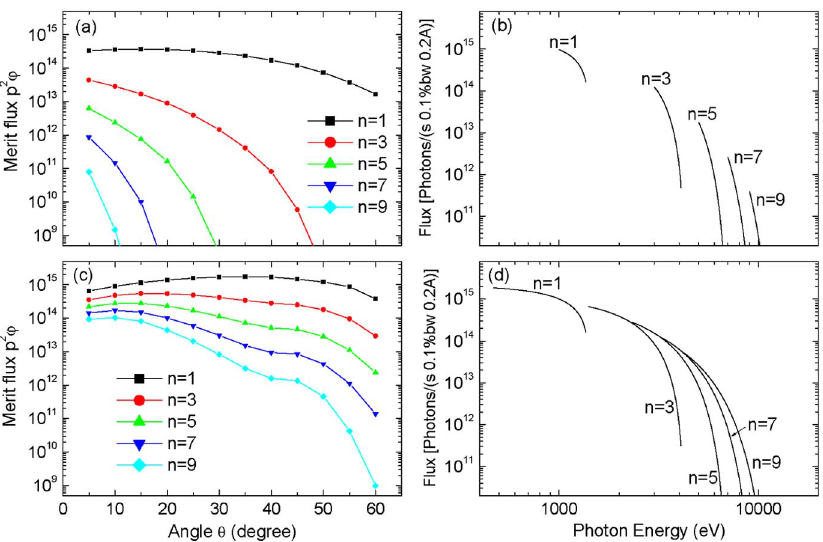
FIG. 9. (Color) Merit flux as functions of rotation angle (cid:6) , and the spectrum of the photon flux, for (a) and (b) the staggered undulator, with the photon flux in (b) calculated at (cid:6) (cid:1) 5 (cid:2) , and for (c) and (d) the racetrack coil undulator, with the photon flux in (d) calculated at (cid:6) (cid:1) 20 (cid:2) . The spectrum was calculated at an electron energy of 1.5 GeV and an electron current of 200